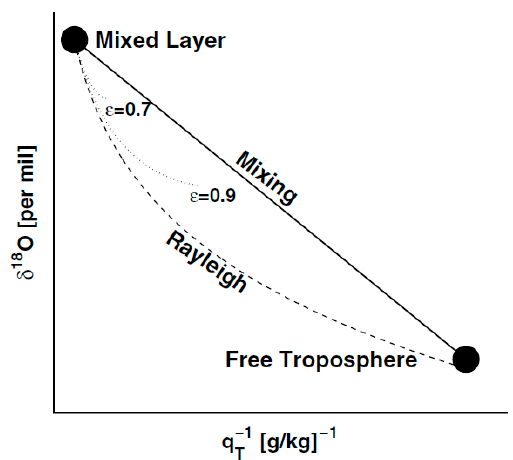
Figure 1. An isotopic mixing diagram of δ 18 O versus the inverse of the total water mixing ratio ( q T-1 ) [34]